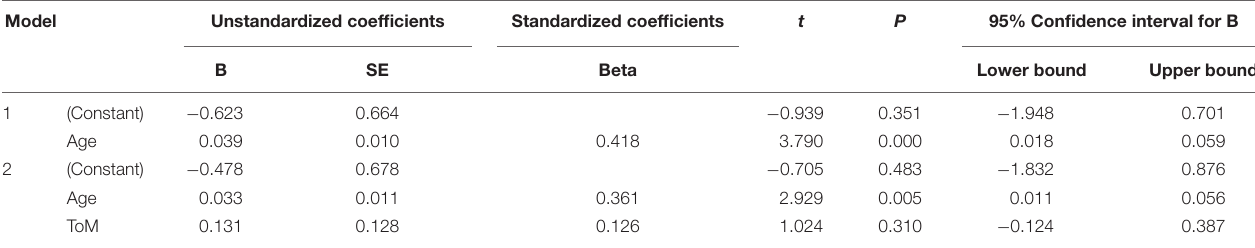
TABLE 2 | Hierarchical linear regression predicting learning judgment in familiar tasks in study 1.